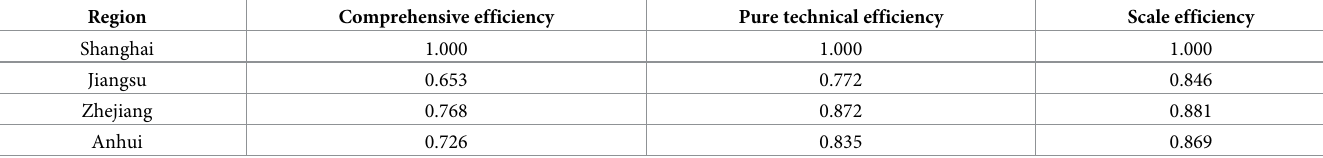
Table 3. The efficiency of innovation resources input-output of province level of YRDUA in 2015.